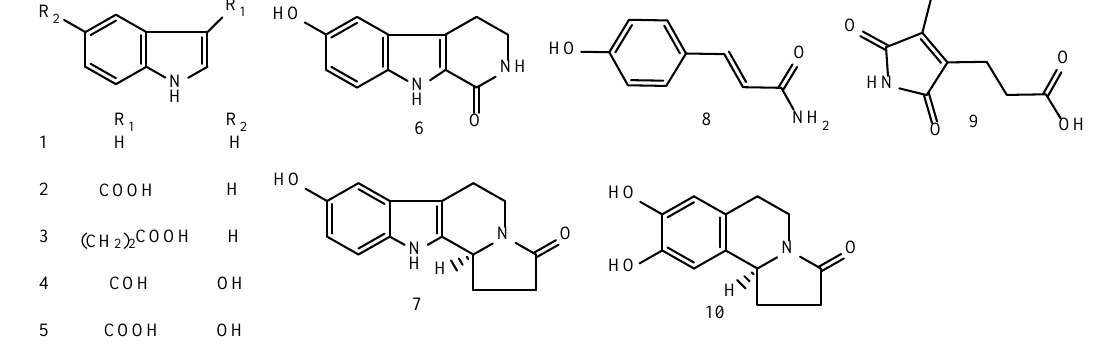
Figure 1. Chemical structures of the alkaloids ( 1 – 10 ) isolated from T. hemsleyanum.